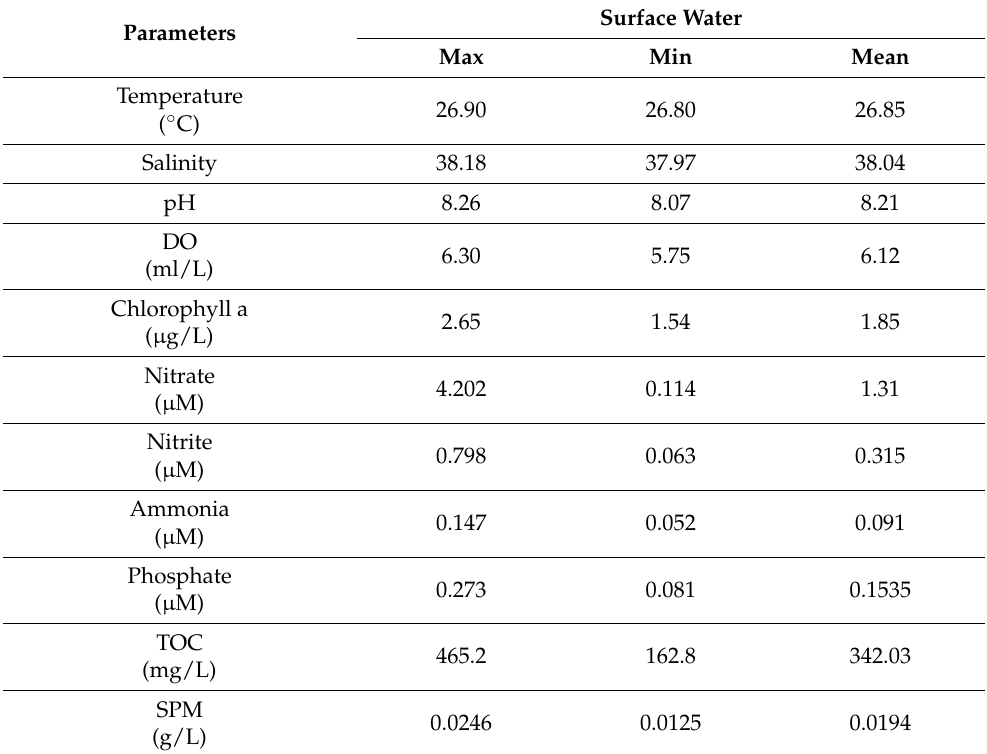
Table 5. Physical and chemical properties of Sharm Obhur